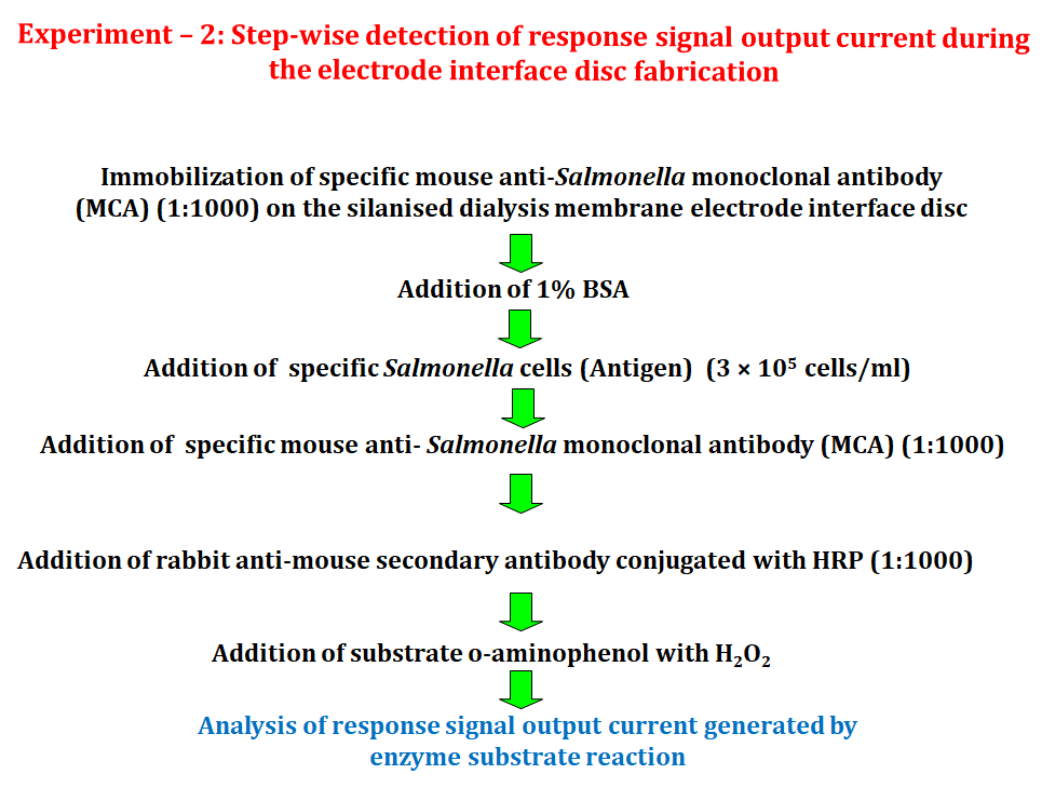
Figure 3. A diagram depicting the various stages involved in the Salmonella cell detection experi-